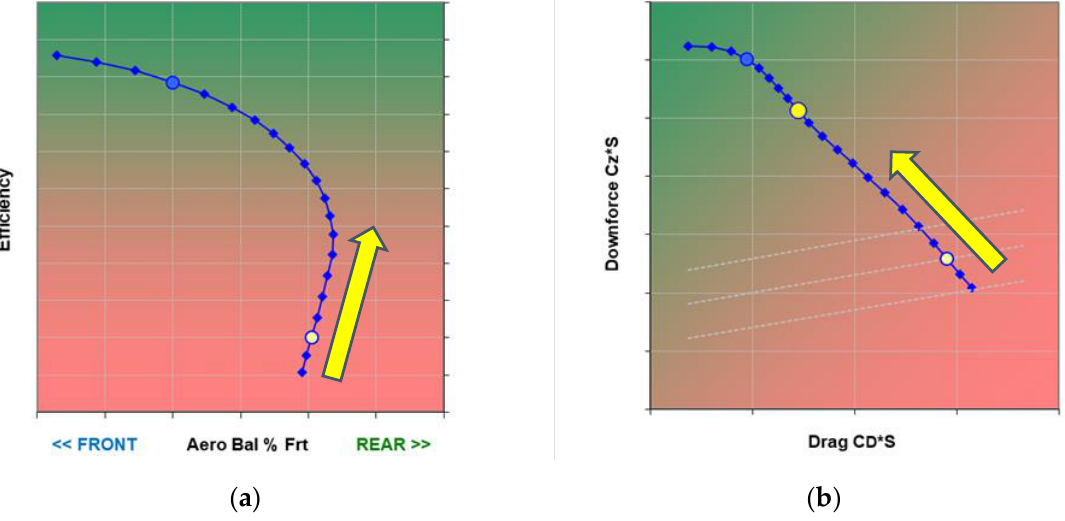
Figure 12. Efficiency vs. Aero Balance and Downforce vs. Drag for the 100 – 300 kph speed range. Yellow arrows show increasing speed. Dotted lines on the second graph are iso-efficiency levels: ( a ) Efficiency vs. Aero Balance ( b ) Downforce vs. Drag. Yellow dots are speed references relevant to a specific circuit.